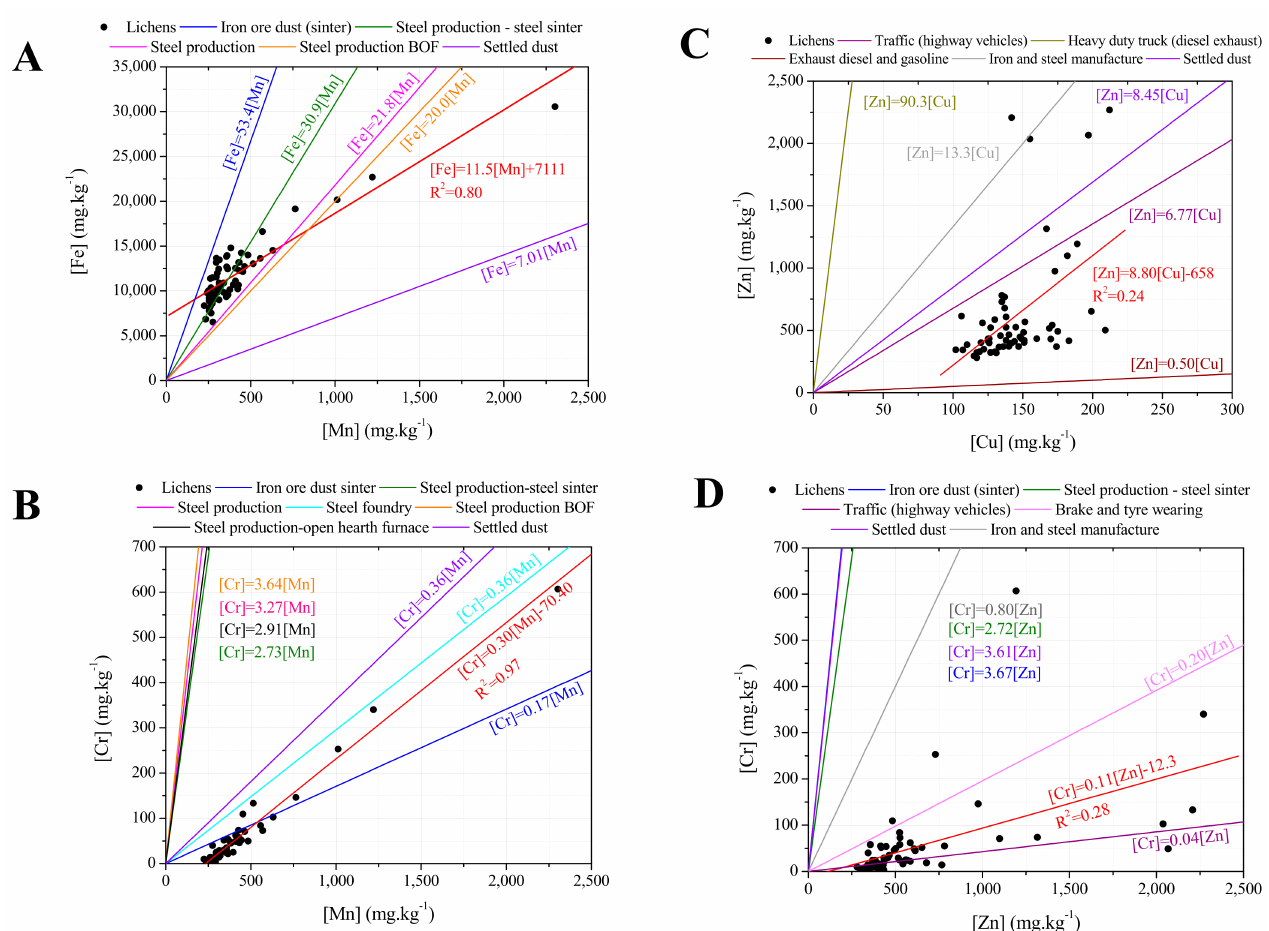
Figure 6. Relation between elements in the exposed lichens, in the settled dust and according to USEPA-SPECIATE and SPECIEUROPE profiles for iron and steel industry and traffic: ( A ) Mn vs. Fe, ( B ) Mn vs. Cr, ( C ) Cu vs. Zn, and ( D ) Zn vs. Cr. The red line presents the linear regression regarding the data of the exposed